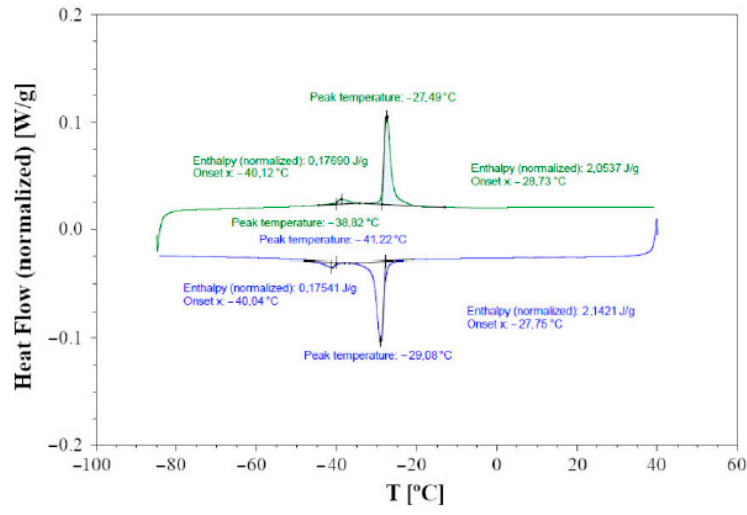
Figure 13. Plot of the DSC data collected on cooling (blue curve) and on heating (green curve) at 5 °C/min on a single crystal of the sample Cu 3 As annealed at 300 °C—13 days. Endothermic heat flow direction is upward.